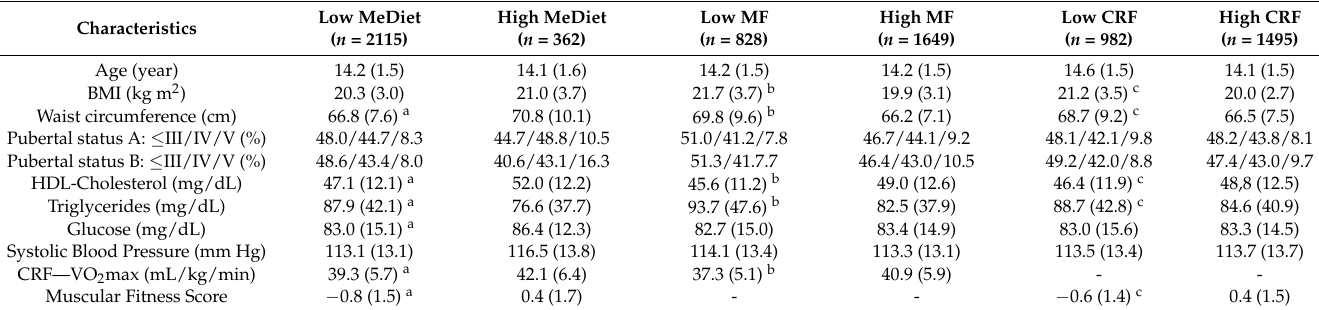
Table 1. Characteristics of participants (mean (standard deviation (SD)) or frequency